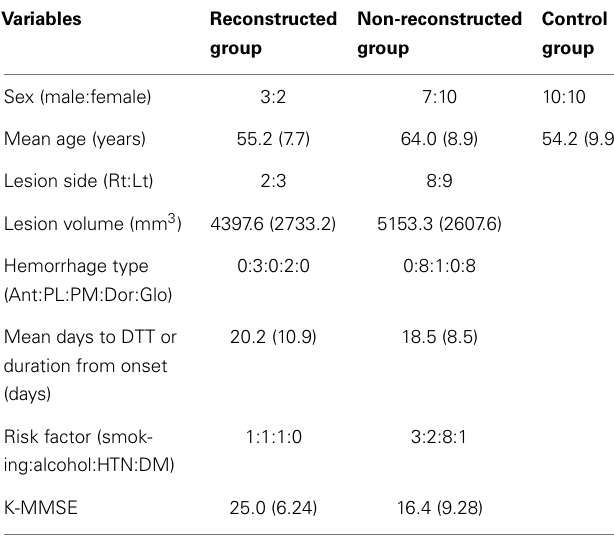
Table 1 | Demographic and clinical data according to diffusion tensor tractography type for the patient and control groups